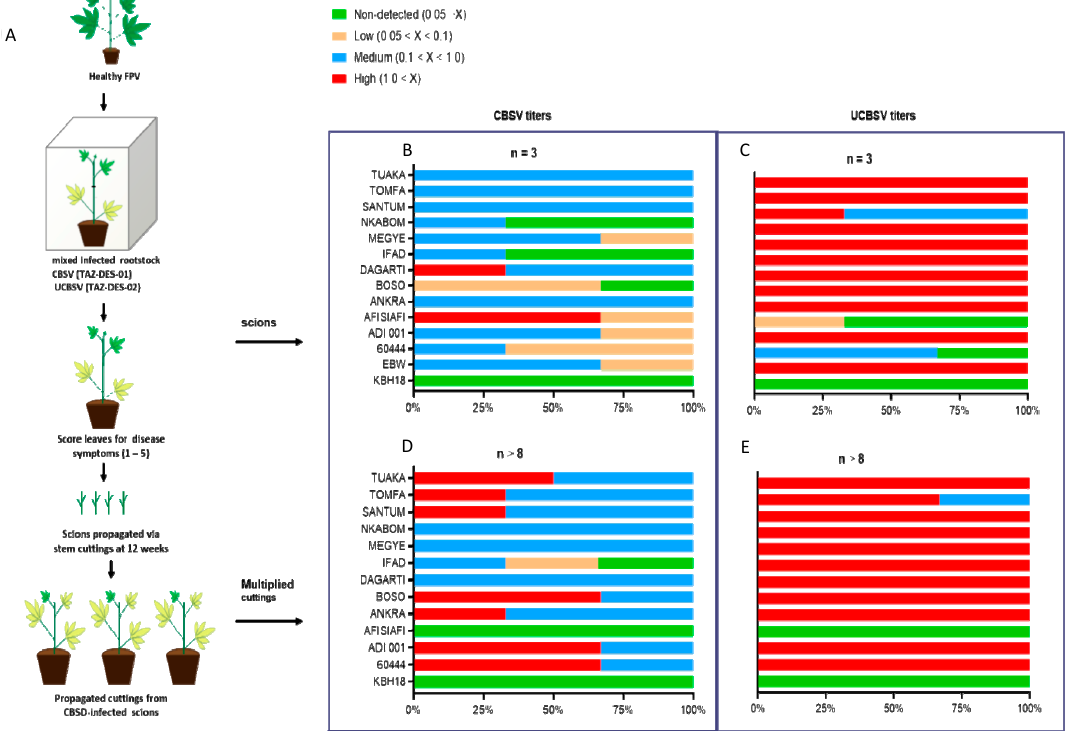
Figure 2. Cassava brown streak virus (CBSV) (TAZ-DES-01) and Ugandan cassava brown streak virus (UCBSV) (TAZ-DES-02) titers in scions and cuttings multiplied from scions at 12 weeks. ( A ) Stringent approach for CBSD screening of Ghanaian cassava cultivars. ( B ) CBSV (TAZ-DES-01) and ( C ) UCBSV titers in scions at 12 weeks post grafting (wpg) (n = 3) and cuttings multiplied from ( D ) CBSD (TAZ-DES-01)- and ( E ) UCBSD (TAZ-DES-02)-infected scions at 12 weeks post multiplication (wpm) (n ≥ 8). CBSV (TAZ-DES-01) and UCBSV (TAZ-DES-02) titers quantitated relative to MePP2A gene. Cuttings made from scions of cultivar Ebwanateraka failed to sprout. X = titers of CBSV (TAZ-DES-01) or UCBSV (TAZ-DES-02) relative to the PP2A gene standard. FPV = farmer-preferred variety.